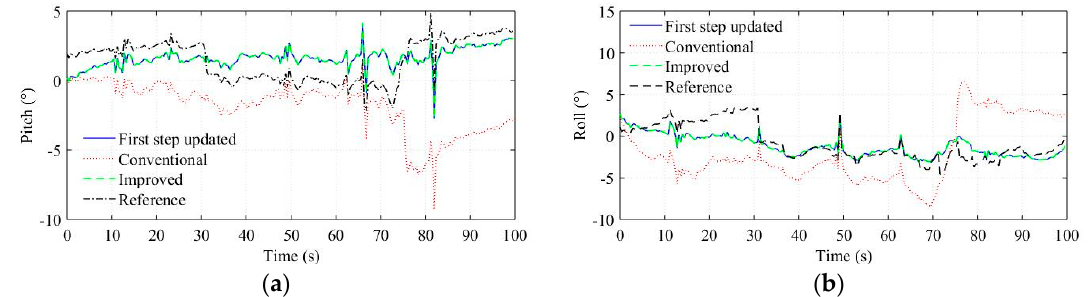
Figure 10. Attitude estimation. ( a ) Pitch estimation. ( b ) Roll estimation.